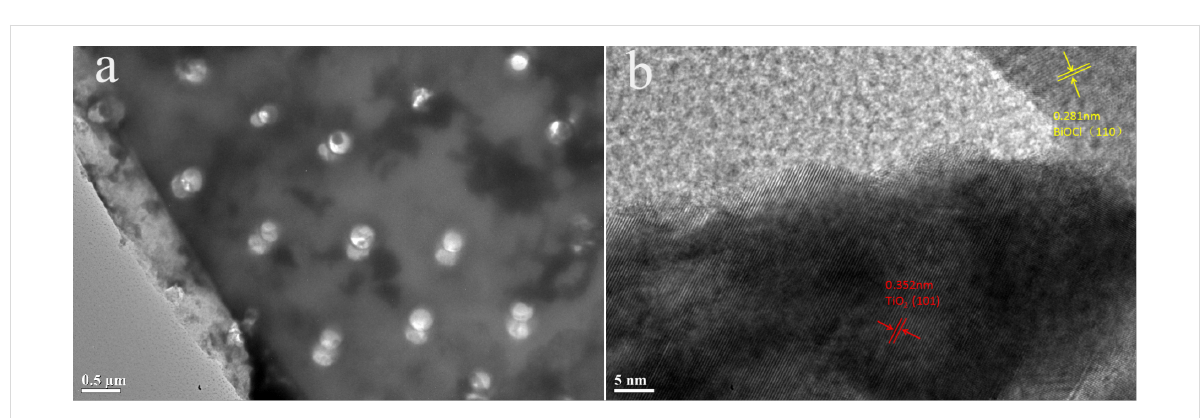
Figure 6: TEM image (a) and high-resolution image showing the lattice fringes (b) of BTD.